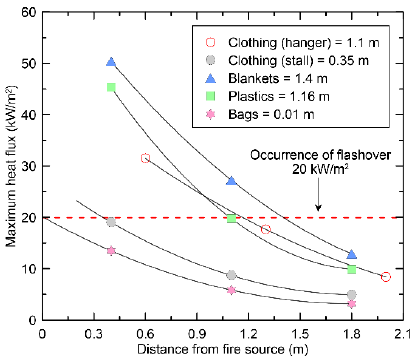
Figure 10. Minimum separation distance to prevent fire spread by radiant heat flux.